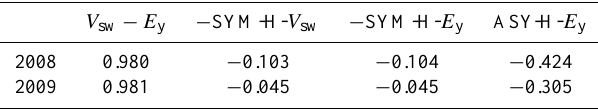
Table 3. Correlation between interplanetary parameters and activity indices in